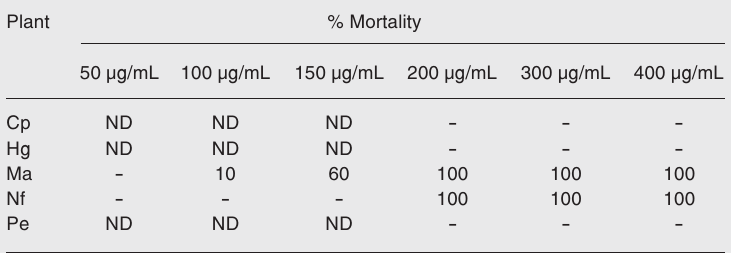
Table 3. Molluscicidal activity of ethanolic extracts of Cayaponia podantha (Cp), Helicteres gardneriana (Hg), Melochia arenosa (Ma), Nectandra falcifolia (Nf), and Paullinia elegans (Pe) against Biomphalaria glabrata .